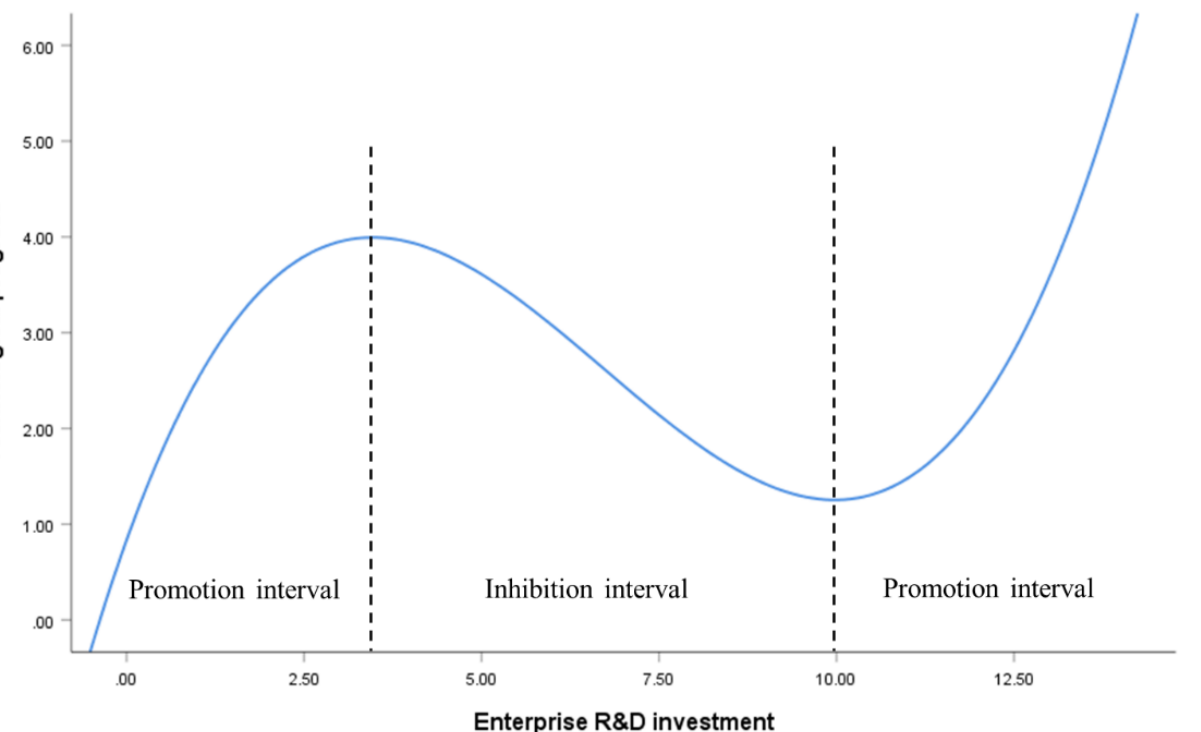
Figure 7. Influence of R&D investment on the technological progress of PV enterprises. Note: En- terprise R&D investment and technological progress are dimensional parameters. Source: Produced by the authors from the sample data using SPSS 16.1.